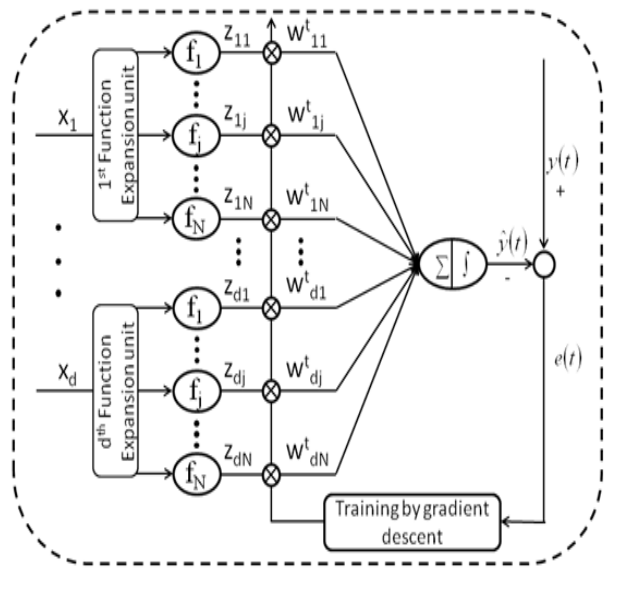
Figure 3 . FLANN based